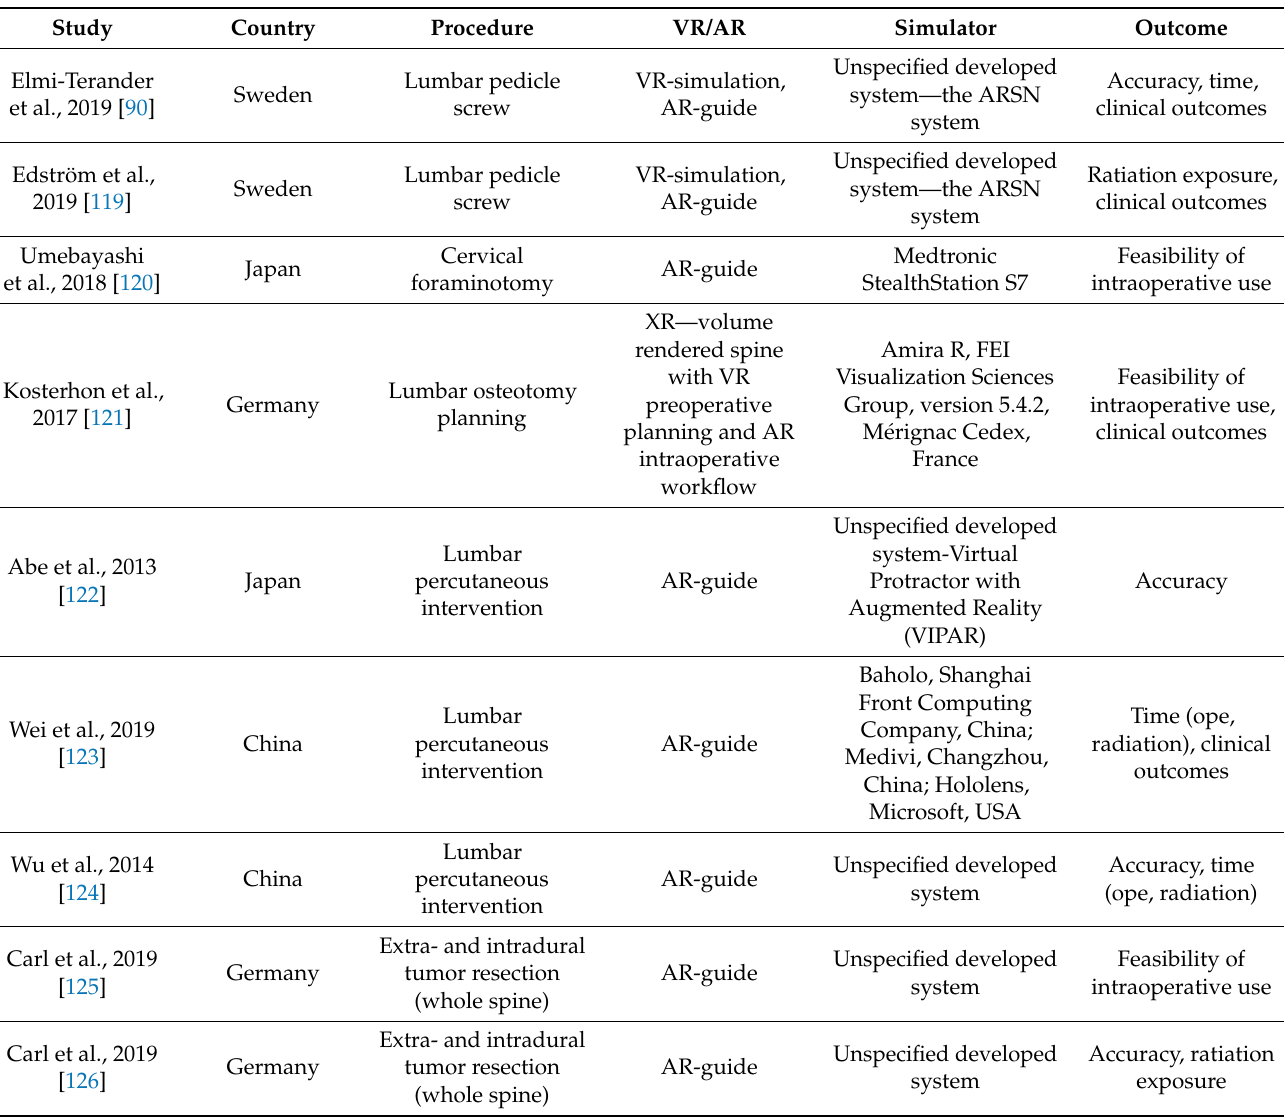
Table 2. A summary of surgical navigation with XR technology in spine